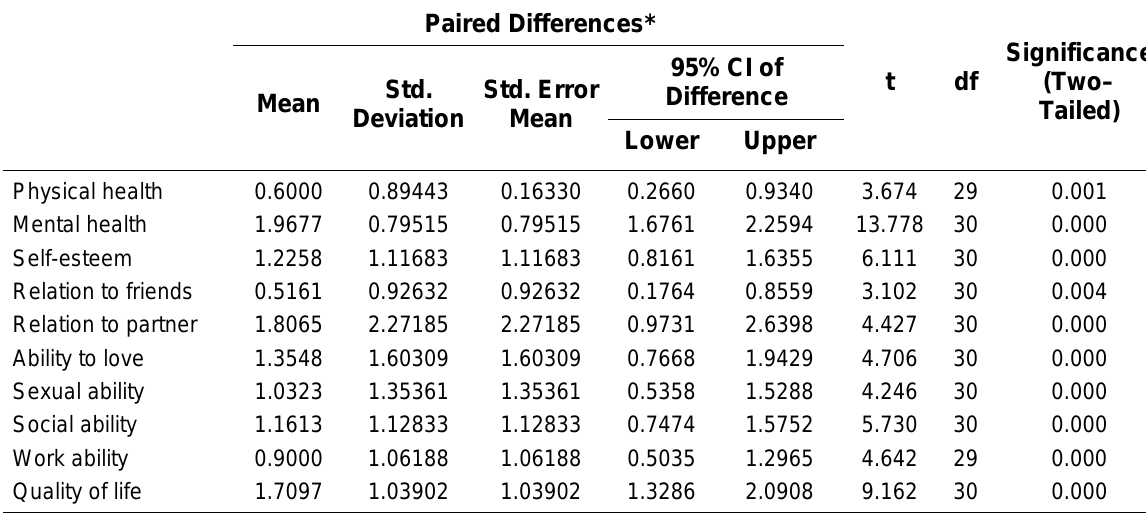
Patients who Changed from Feeling Mentally Ill to Mentally